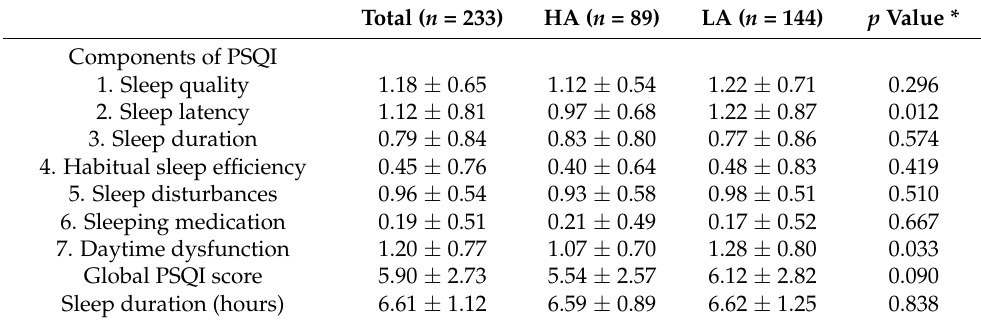
Table 3. Sleep pattern according to acculturative degree.